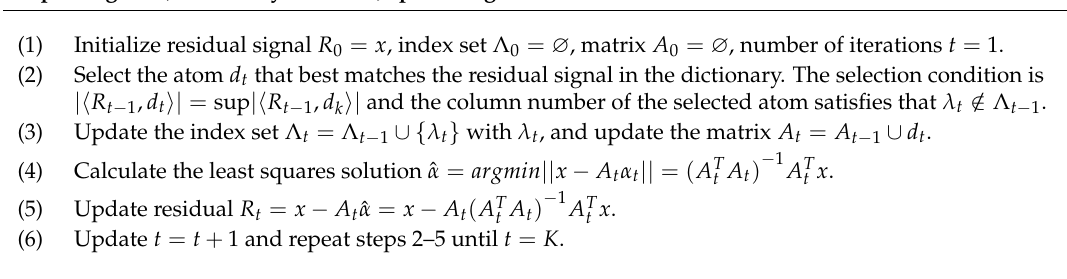
Table 1. Workflow of orthogonal matching pursuit